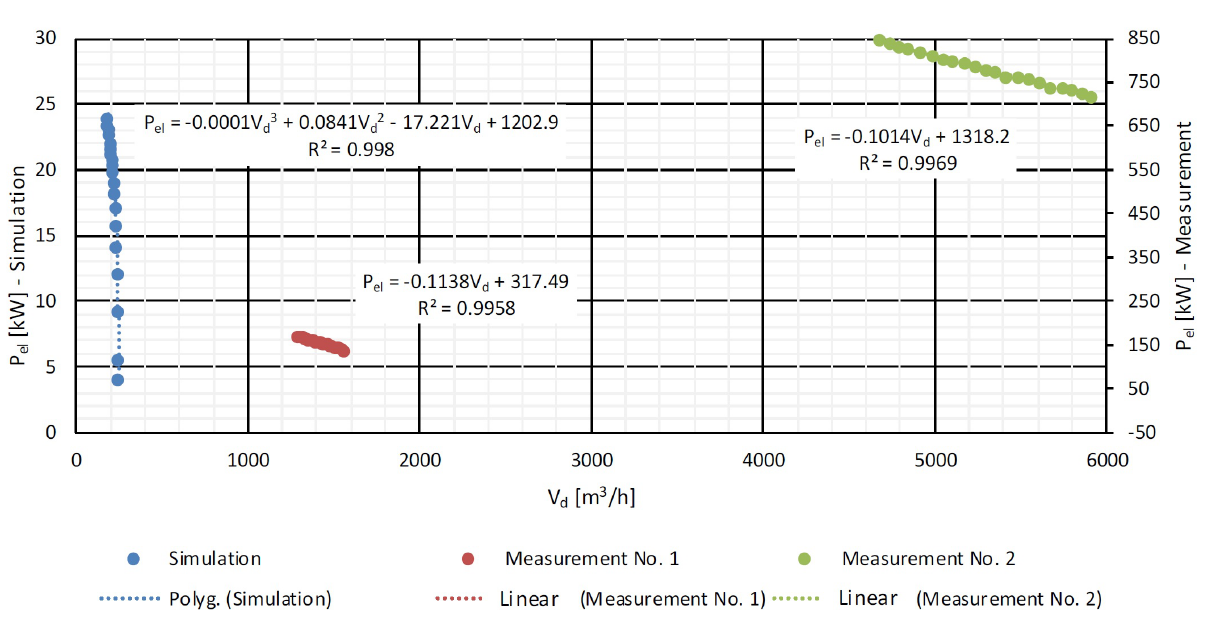
Figure B2: Power consumption characteristics